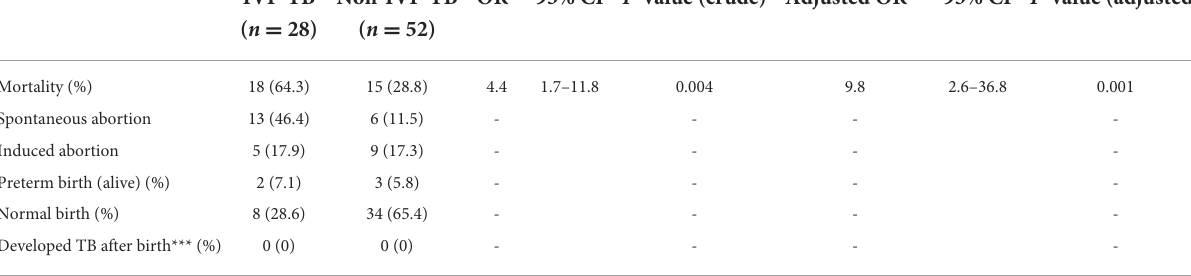
TABLE 3 Association between IVF status and perinatal outcome among TB-in-pregnancy